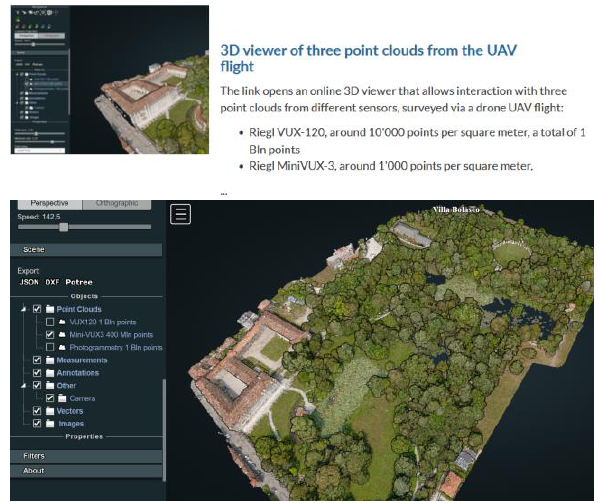
Figure 3. Large volumes of data from point clouds linked via metadata.